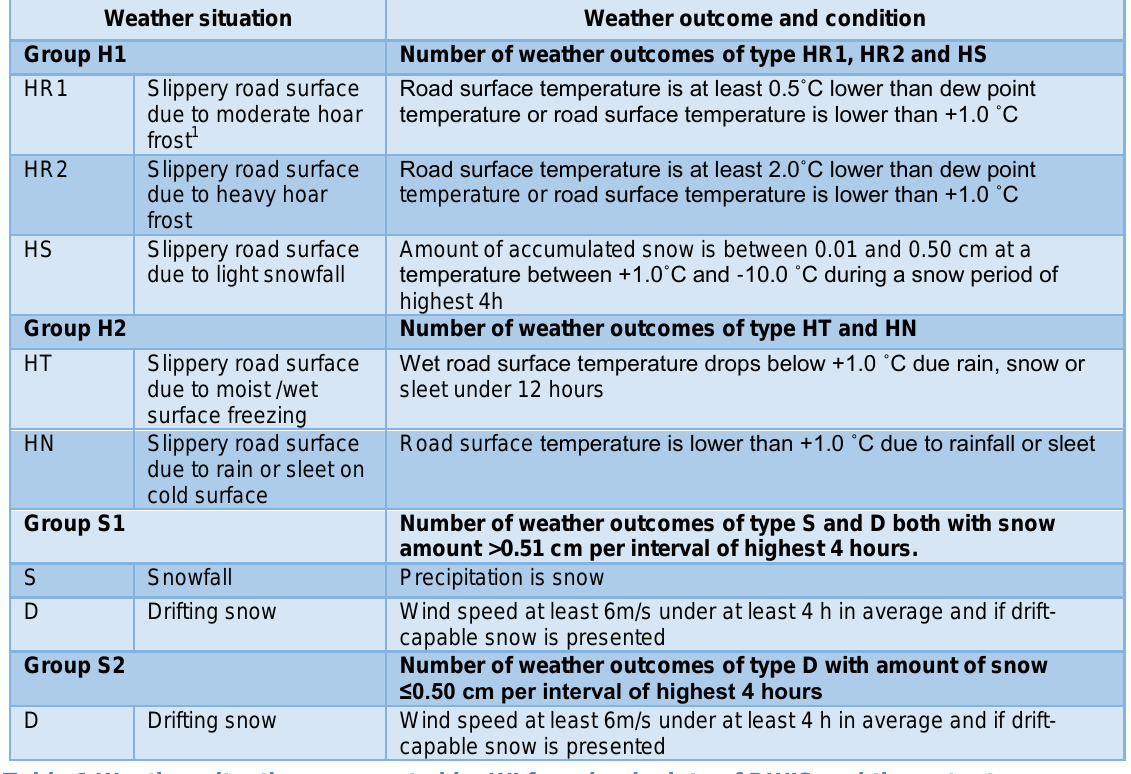
Table 1 Weather situations generated by WI from basic data of RWIS and the output groups (Source: STA,